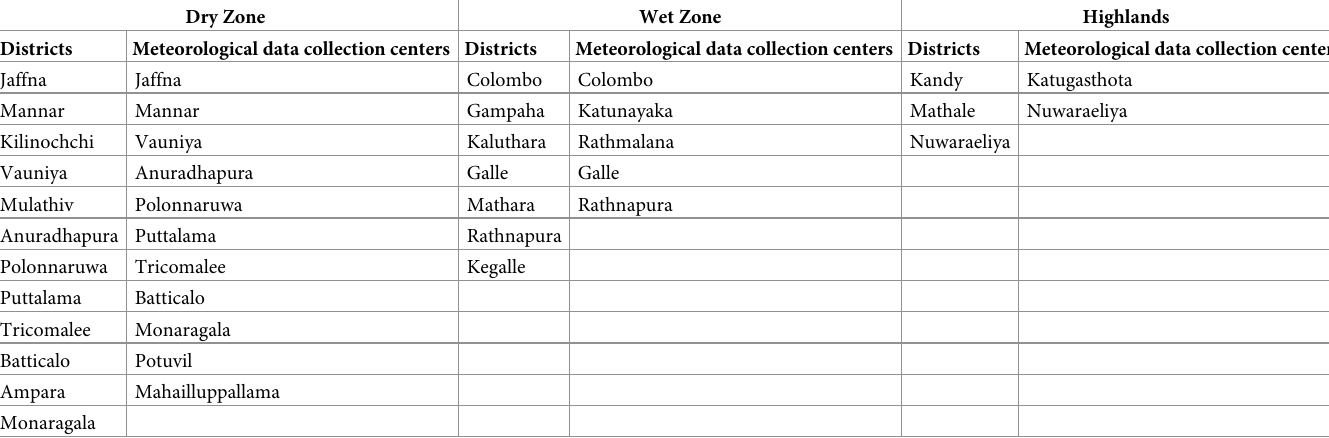
Table 1. Districts and meteorological data collection sites within Sri Lanka according to meteorological